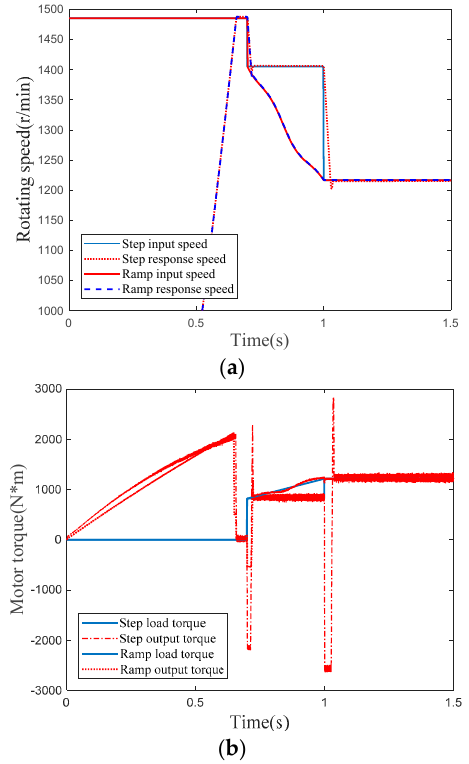
Figure 10. Torque and speed response curves under different signals: ( a ) torque response and ( b ) rotating speed response.